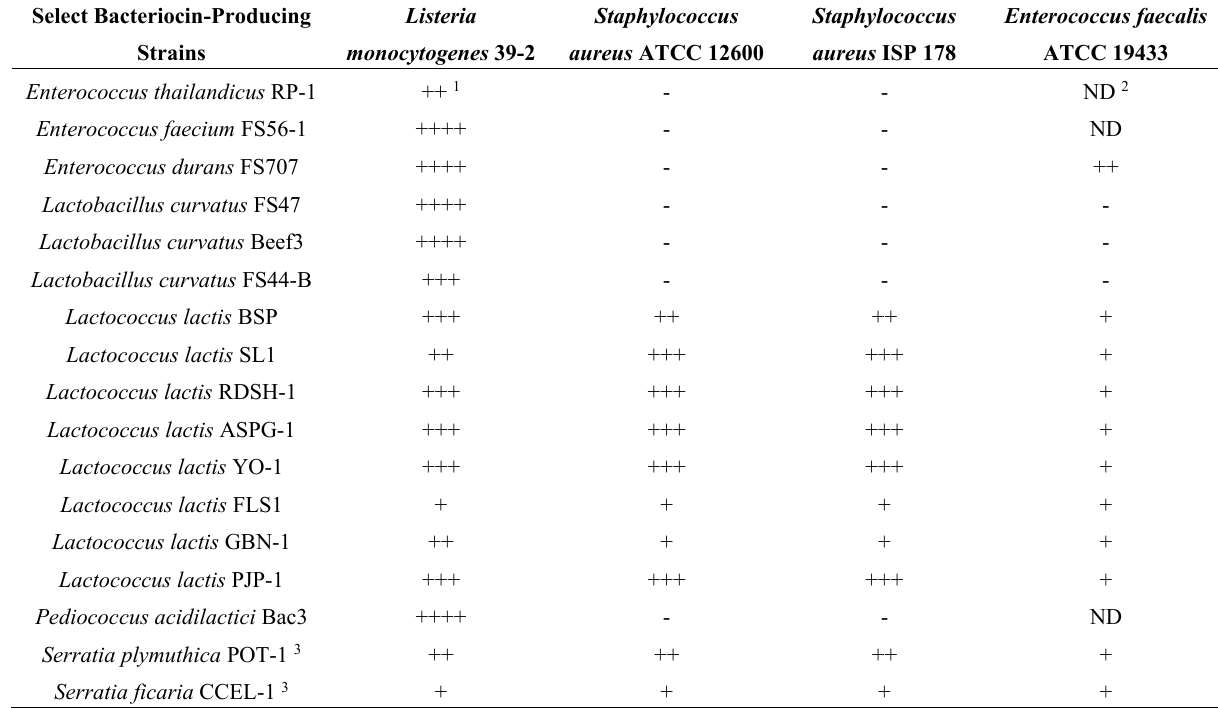
Table 2. Inhibitory activity elicited by select Bac + strains against various foodborne pathogens. Select